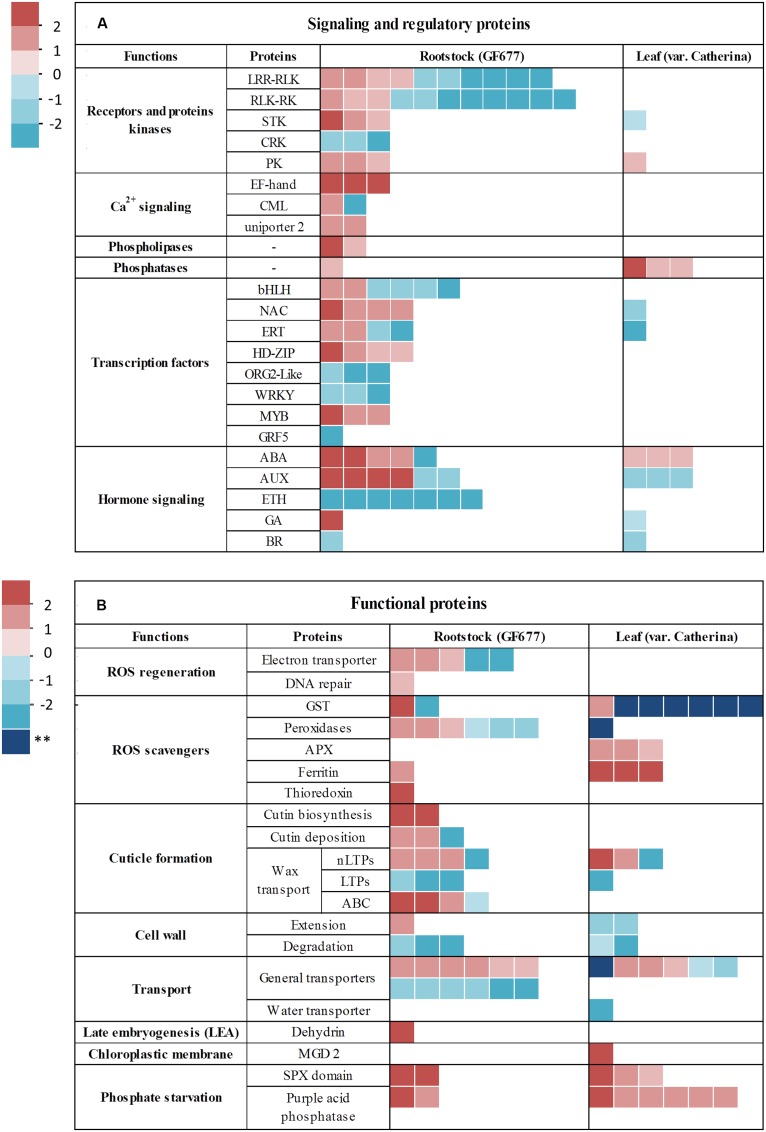
Levels of expression of DEGs identified in roots (GF677 rootstock) and leaves (graft, var. Catherina). (A) DEGs involved in signaling and regulatory processes. (B) DEGs involved in functional processes. Details are provided in Supplementary Table S3. The scale bar on the left represents the observed changes in expression in terms of Log2FC from upregulation (red squares) to downregulation (blue squares). The dark blue pattern with stars indicates genes uniquely expressed in leaves in the control group. The fold change was calculated as the ratio between the drought-stressed and control plants. ERT, ethylene-responsive transcription factor; GRF5, growth-regulating factor 5; ABA, abscisic acid; ETH, ethylene; AUX, auxin; GA, gibberellin; BR, brassinosteroid; APX, ascorbate peroxidase; nLTPs, non-specific-lipid transfer proteins; LTPs, lipid transfer proteins; ABC, ATP-binding cassette.